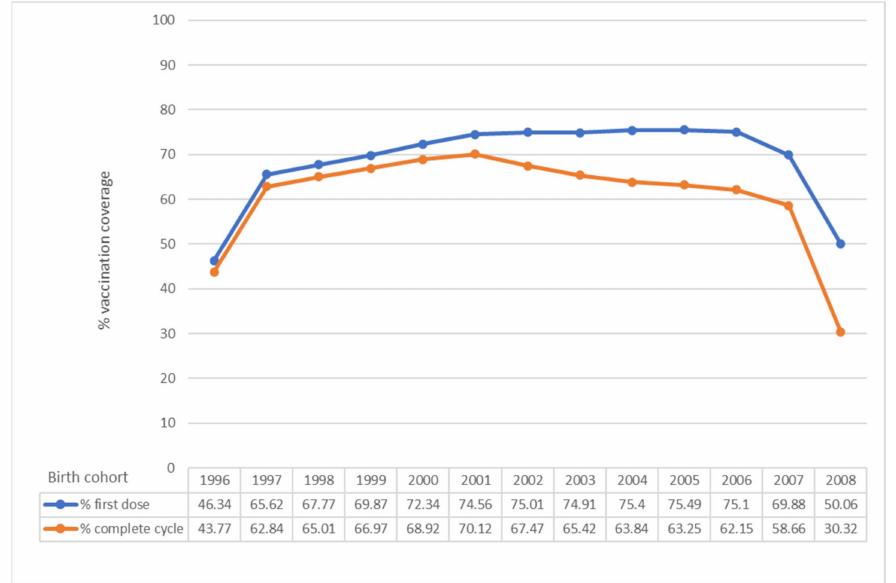
Figure 1. HPV vaccination coverage in Italy, observed year 2020. First dose and complete cycle per birth cohort (females). Data updated to 31 December 2020 (modified by